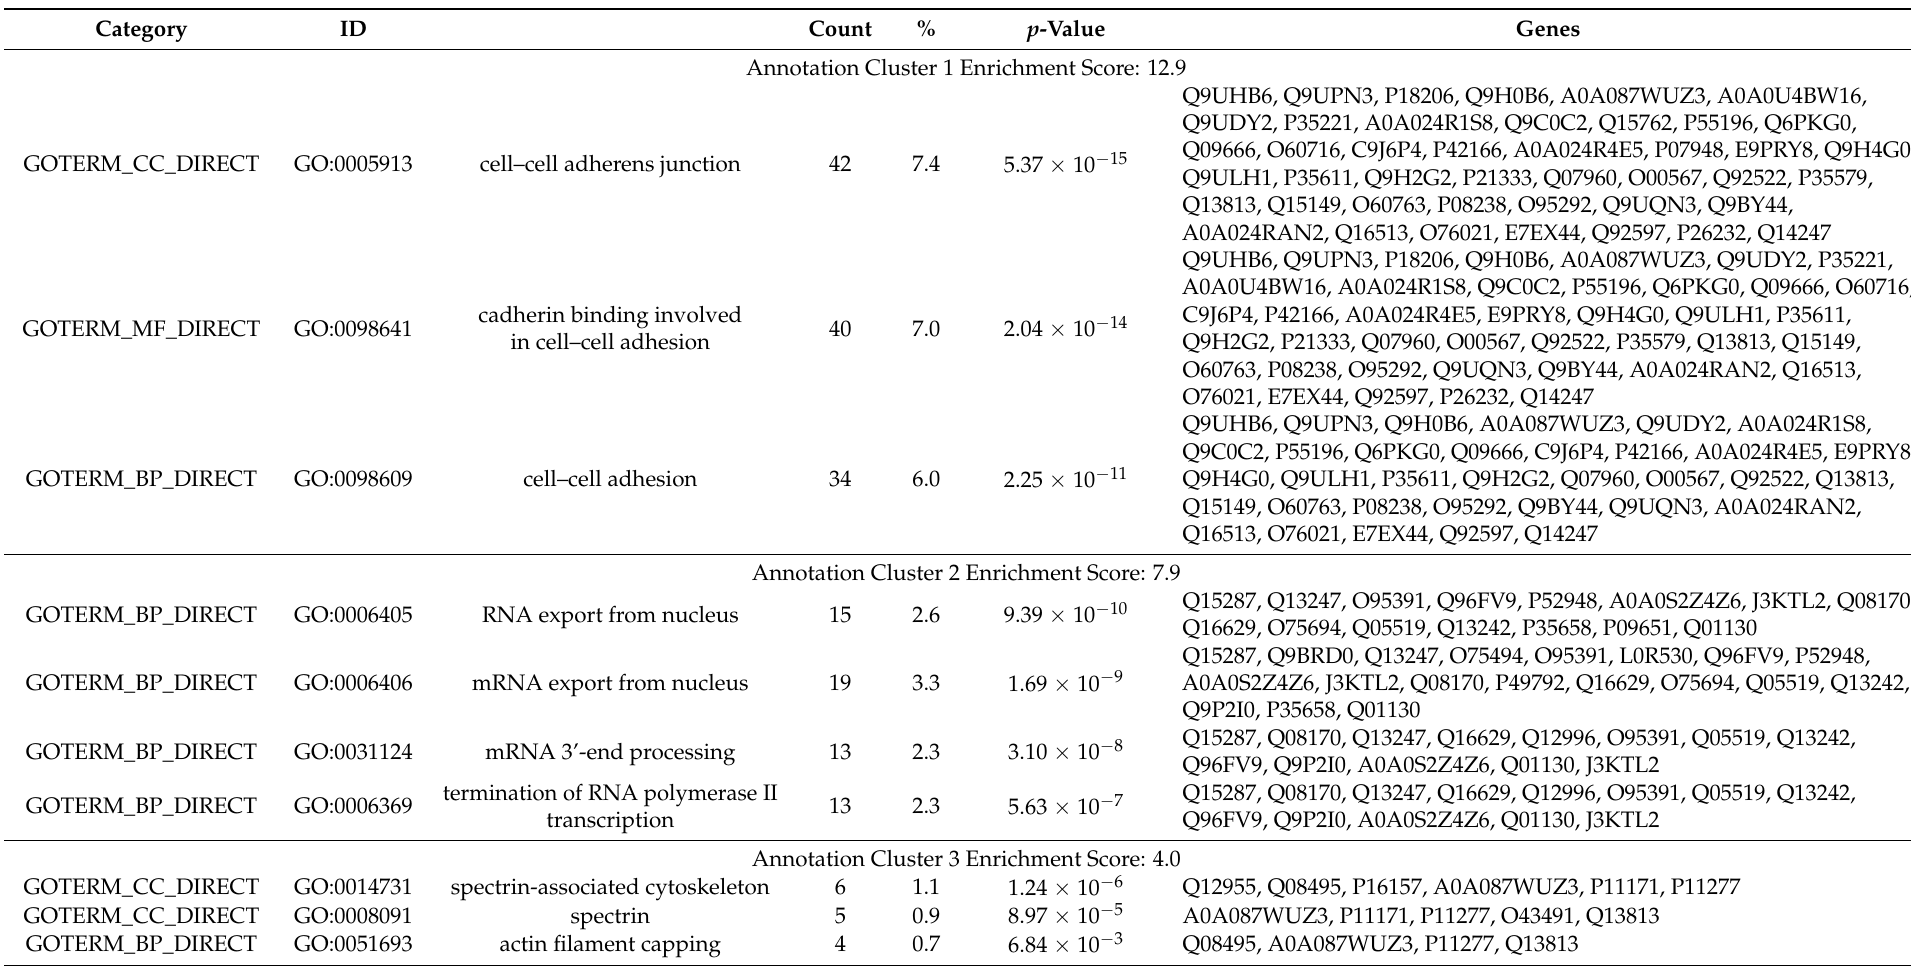
Table 1. The clustered functional characteristics of differentially phosphorylated proteins in human nonfunctional